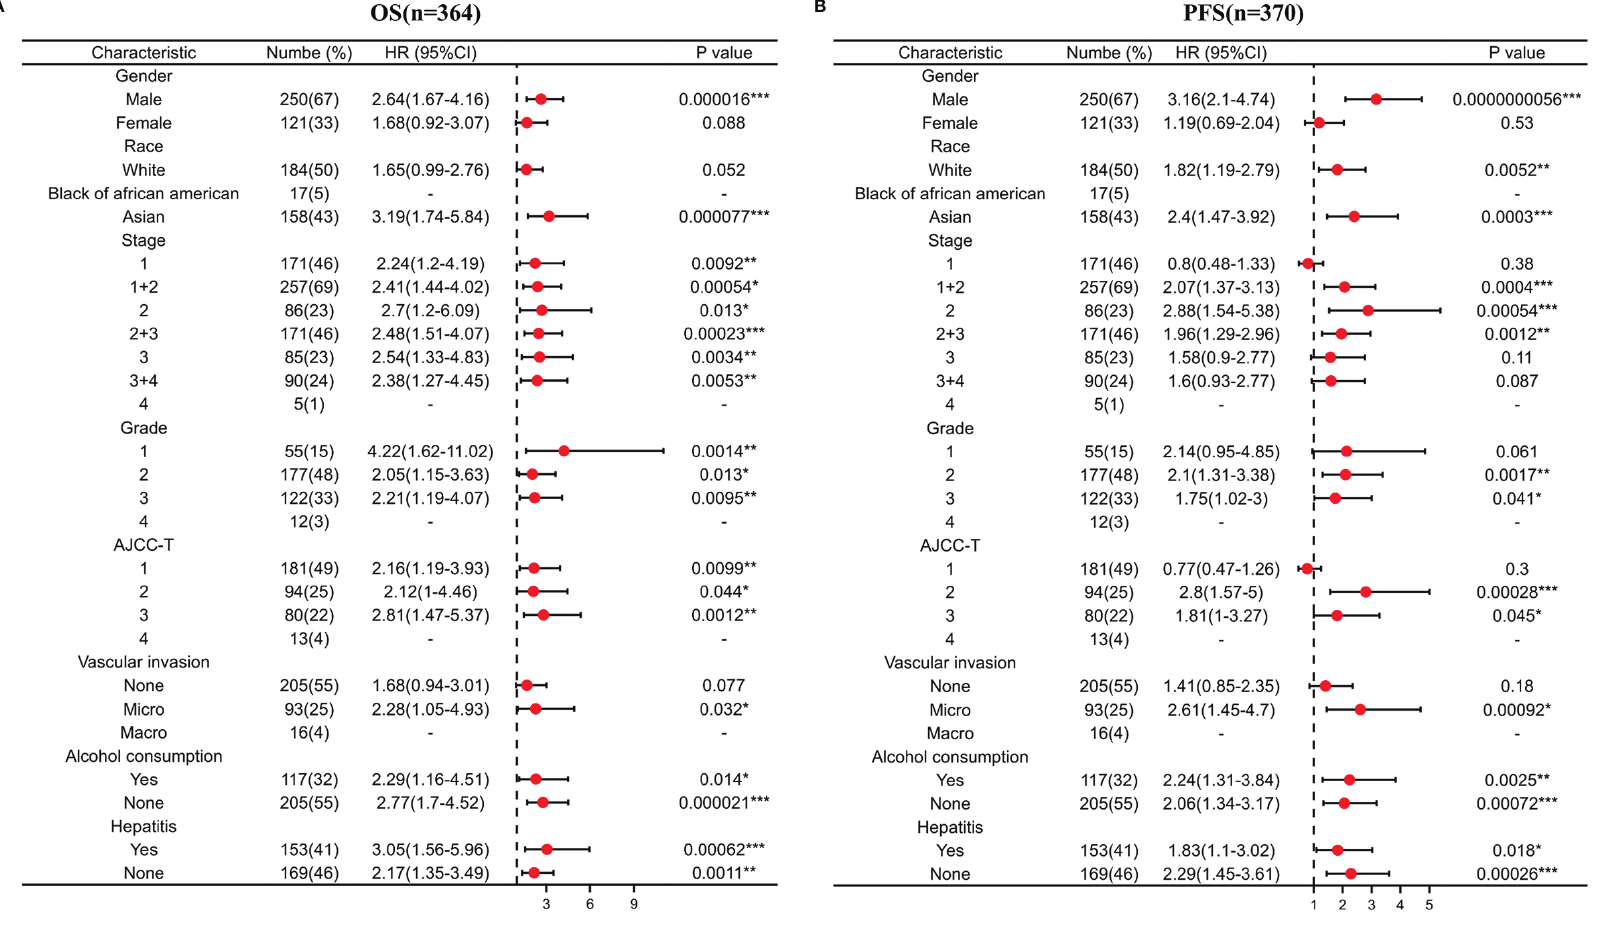
FIGURE 3 | Correlation of ACYP1 expression from LIHC patients in various clinicopathologies with OS (n=364) (A) and RFS (n=370) (B) . Red dots represent the hazard ratio. OS, overall survival; PFS, progression- free survival. *P < 0.05, **P < 0.01, ***P <